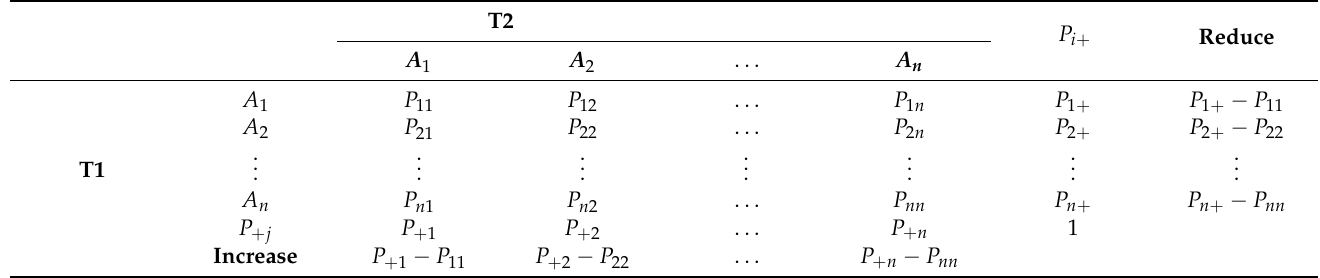
Table 1. General form of the land use transition matrix.